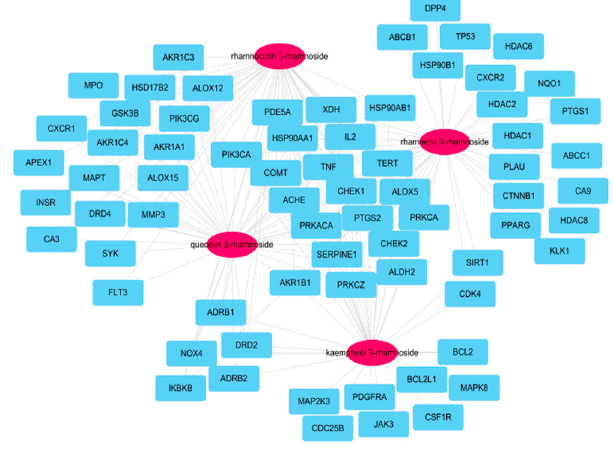
Figure 2. Network of four molecules (pink oval) and 70 potential target genes (cyan rectangles); this network consisted of 74 nodes and 160 edges.